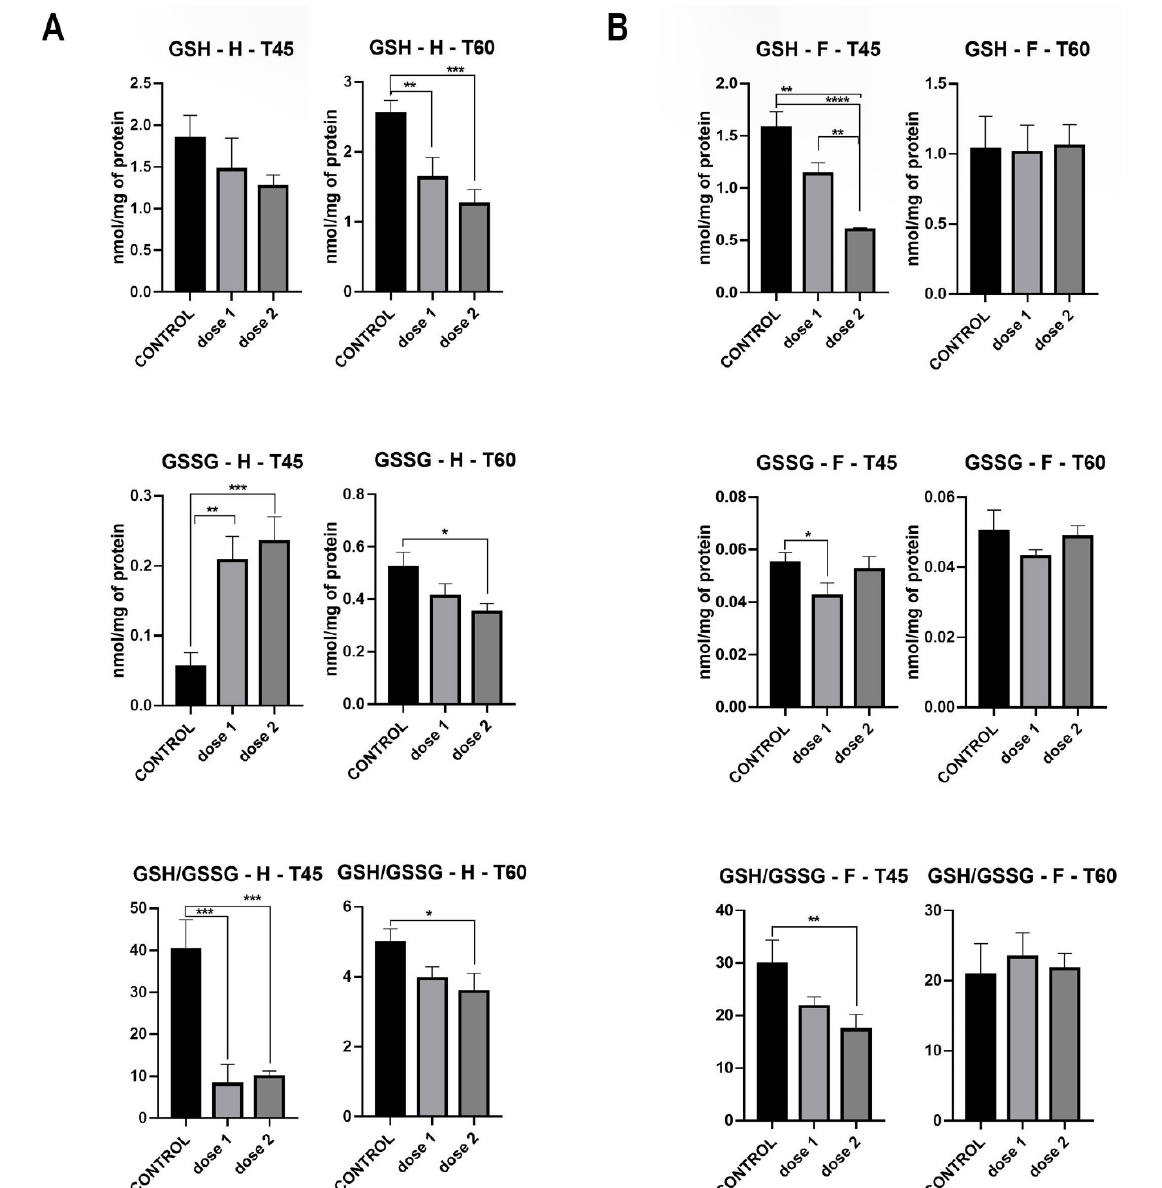
Figure 7. GSH and GSSG levels, GSH/GSSG ratio in hippocampus ( A ) and frontal lobe ( B ) of groups sacrificed immediately after treatment (T45) and those sacrificed 15 days post-treatment (T60). * p < 0.05; ** p < 0.01; *** p < 0.001; **** p < 0.0001.